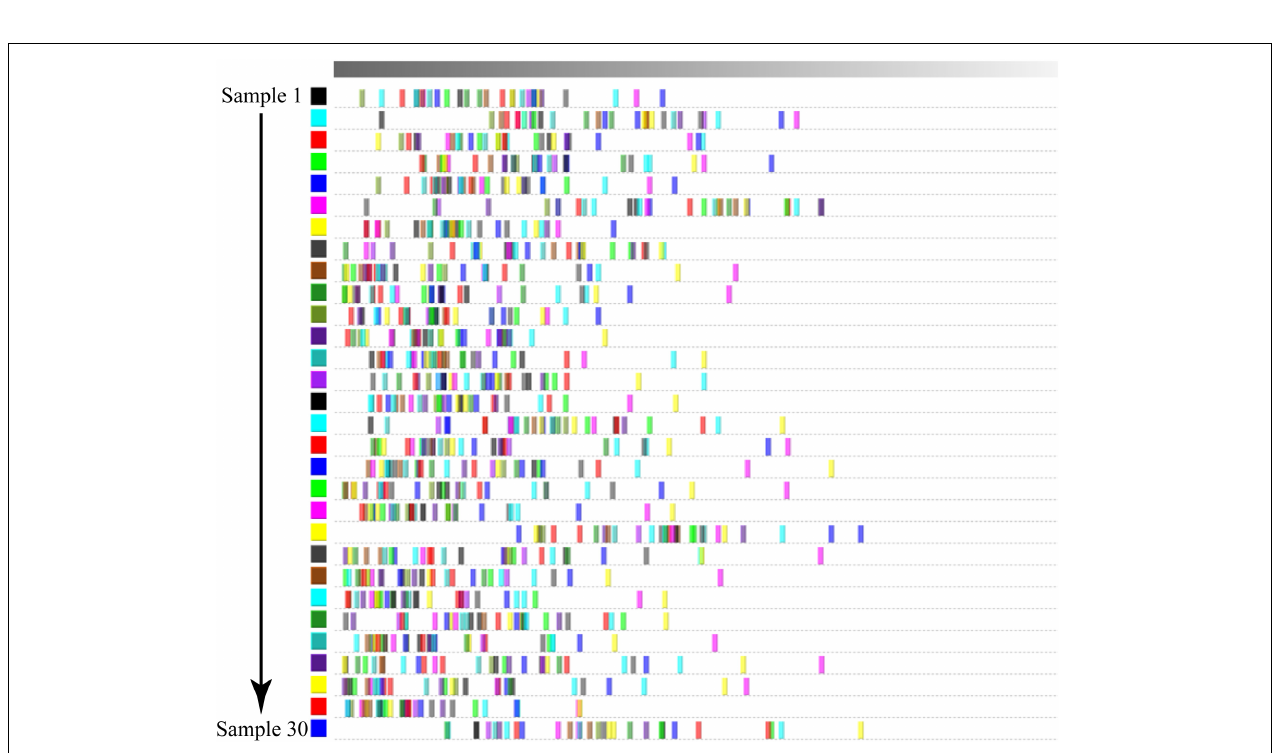
FIGURE 5 | PCA of flavor components of Dongxiang tribute mutton.